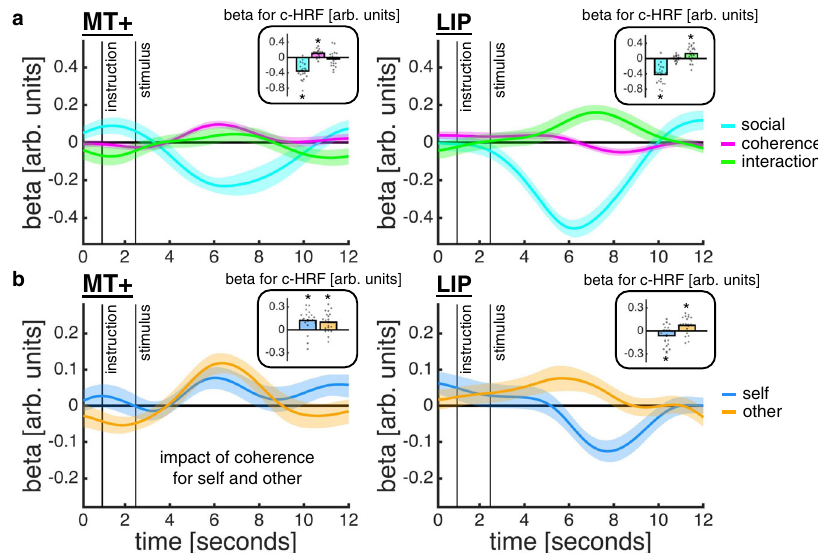
Fig. 6 Encoding of motion coherence in MT + and LIP. a The time courses are coef fi cients from a regression in which we predicted z-scored MT + (left) and LIP (right) activity time courses using trial type (cyan; other = 0.5; self = − 0.5), z-scored motion coherence (pink) and their interaction (green). The insets show coef fi cients from an analysis of canonical HRFs (c-HRFs; asterisk indicates statistical signi fi cance, p < 0.05, one-sample t -test against zero). b Same approach as in a , but now quantifying the impact of motion coherence separately for each trial type. a – b Data are represented as group mean ± SEM, n = 21. Source data are provided as a Source Data fi le.